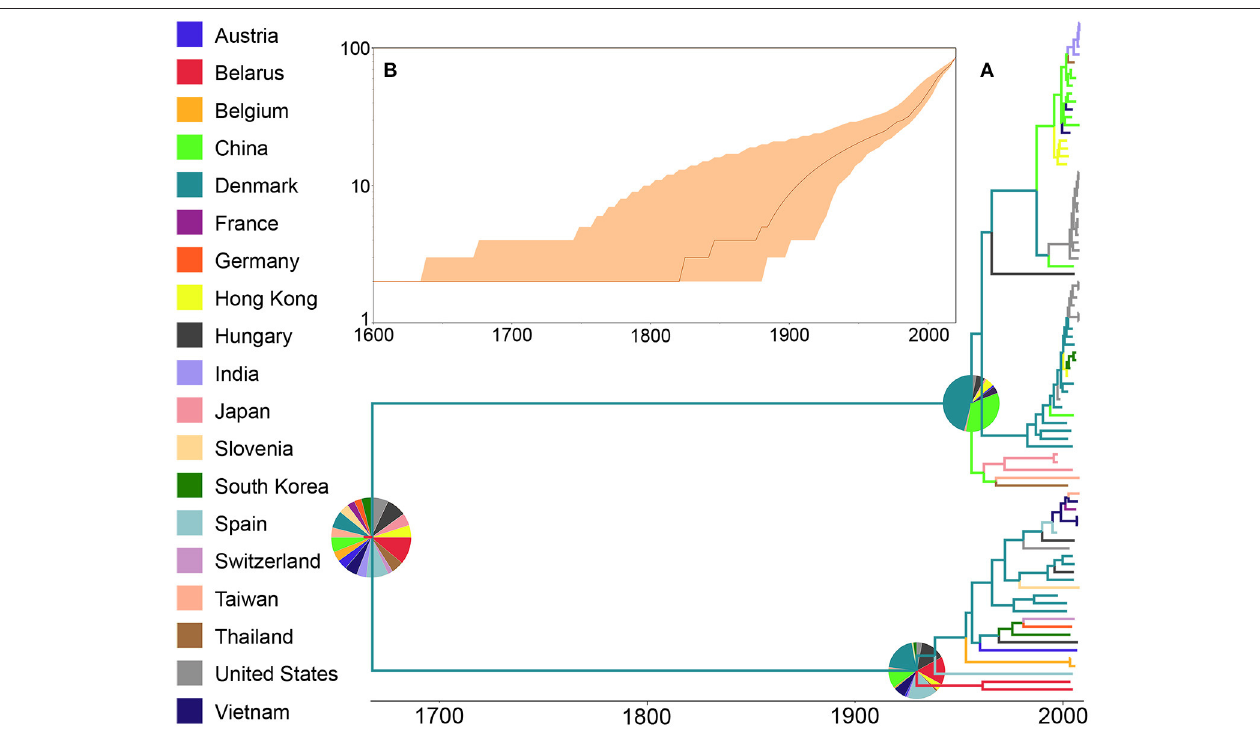
FIGURE 3 | Phylogenetic history of PRRSV inferred using ORF5 sequences. (A) Maximum clade credibility (MCC) phylogeny, colored according to the country of origin of each sequence. The probabilities of ancestral states (inferred from the Bayesian discrete-trait analysis) are shown in pie charts on each node. (B) Spatiotemporal patterns represented through lineages through time plot.